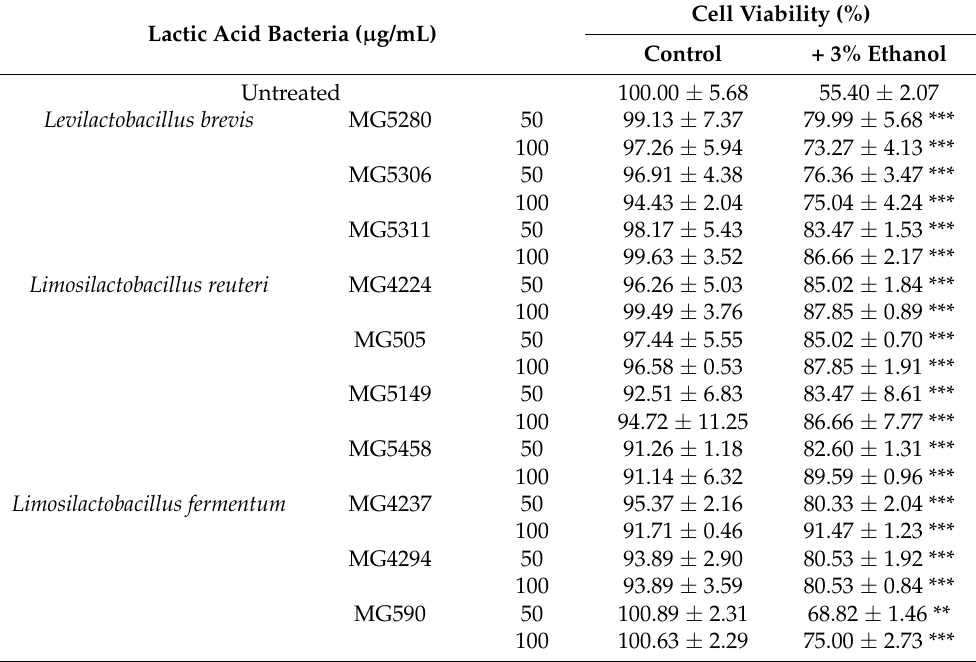
Table 1. Effect of CFEs from LAB strains on the viability of HepG2 cells exposed with or without ethanol. Lactic Acid Bacteria ( µ